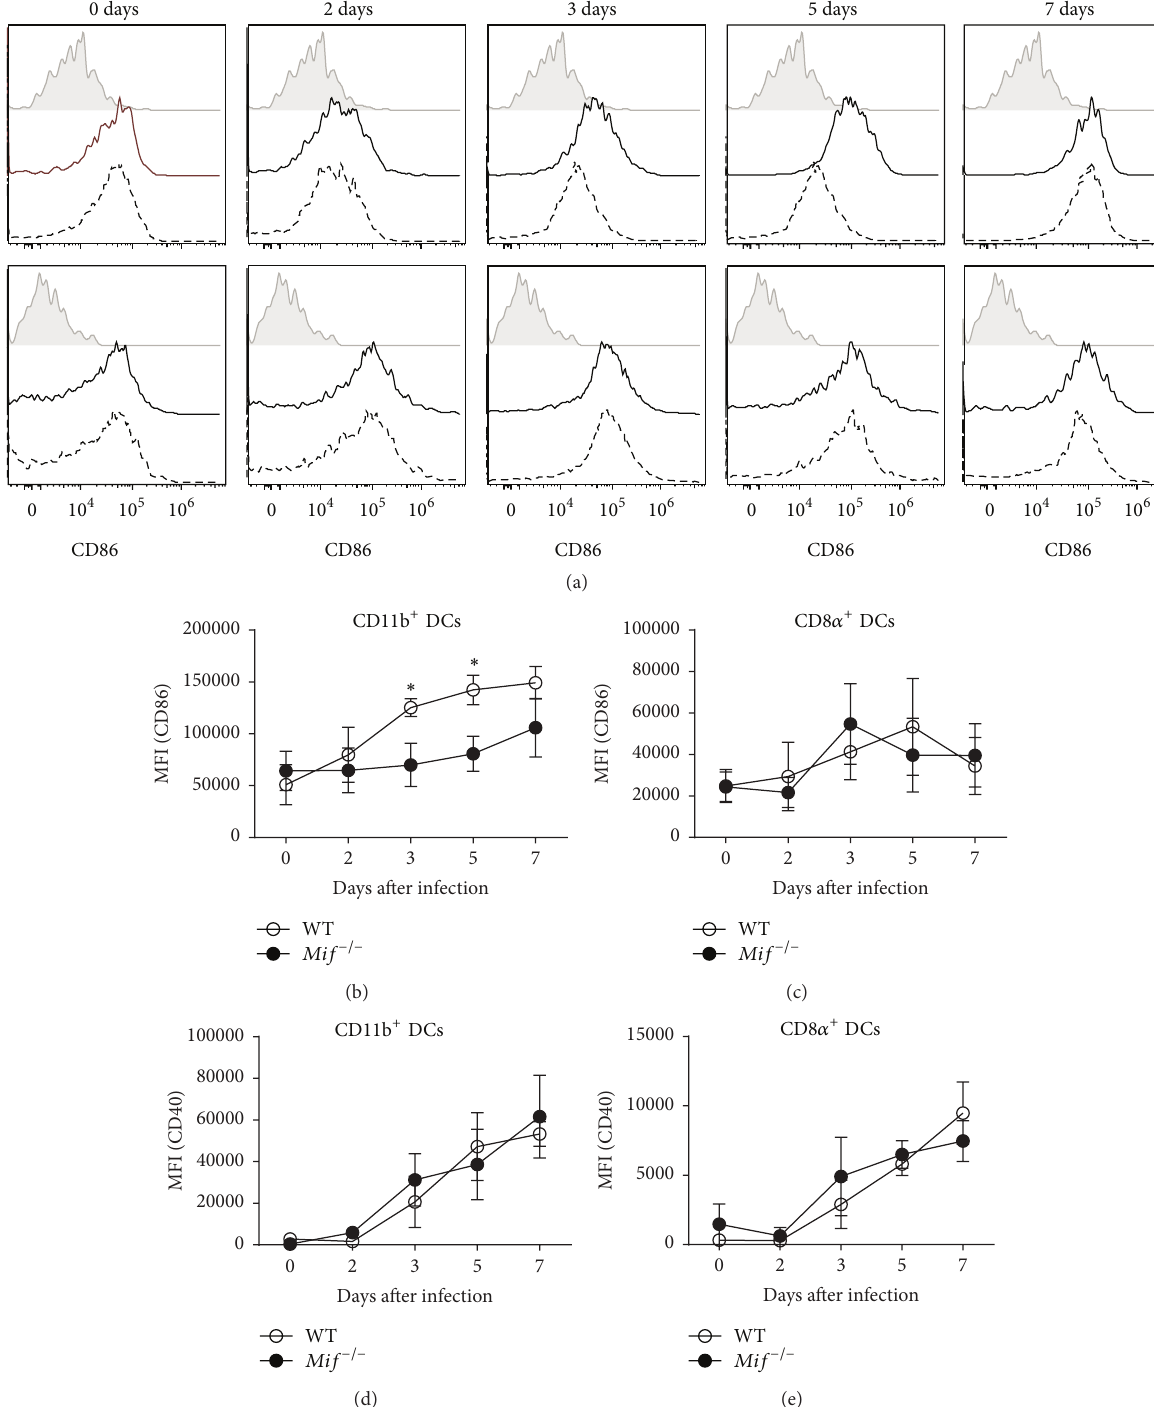
Figure 3: MIF induces CD86 expression on conventional CD11b + DCs but not CD8 𝛼 + DCs. Analysis of CD86 and CD40 expression on MHCII + CD11c + CD11b + and MHCII + CD11c + CD205 + CD8 𝛼 + DCs from infected WT mice (solid line), Mif −/− mice (dashed line), and isotype (gray) at 0, 3, and 5 days after T. gondii infection. (a) Representative histograms of CD86 mean fluorescence intensity (MFI) in MHCII + CD11c + CD11b + DCs and MHCII + CD11c + CD205 + CD8 𝛼 + DCs. (b) MFI kinetics of CD86 in CD11b + DCs. (c) MFI kinetics of CD86 in CD8 𝛼 + DCs. (d) MFI kinetics of CD40 in CD11b + DCs. (e) MFI kinetics of CD40 in CD8 𝛼 + DCs from WT ( I ) and Mif −/− ( e ) ( 𝑛 = 3 animals at each time point, representative of 2 independent experiments). Data are presented as the mean ± SE. ∗ 𝑃 < 0.05